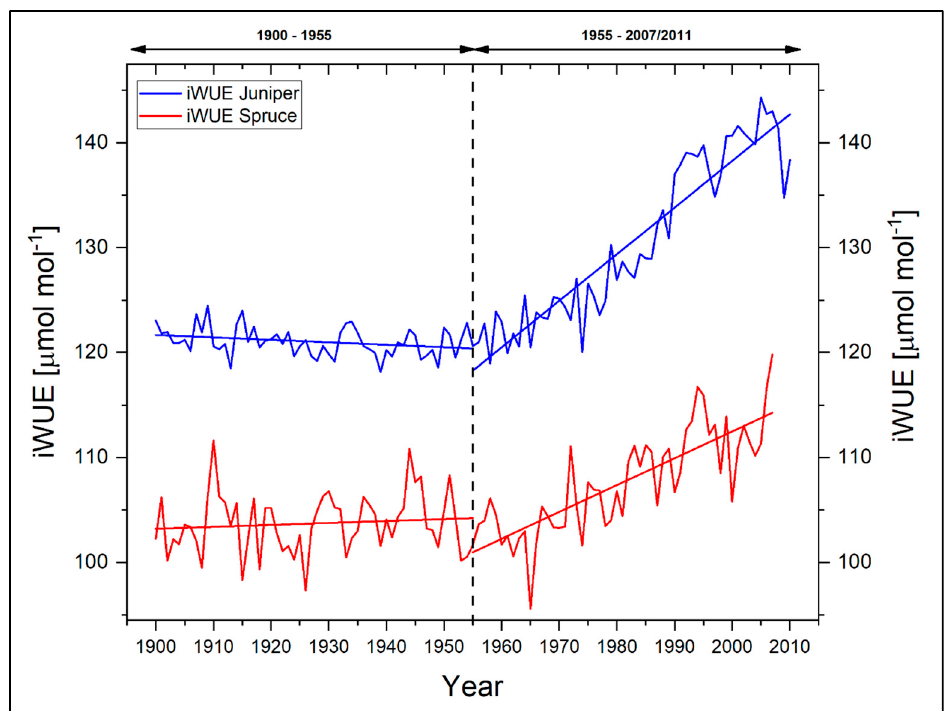
Figure 8. Intrinsic water-use efficiencies for Juniperus tibetica and Picea balfouriana at Qamdo. Dashed line indicates dividing line between the investigation periods, while old lines represent the individual linear trends of both species for the periods 1900–1954 and 1955–2007,